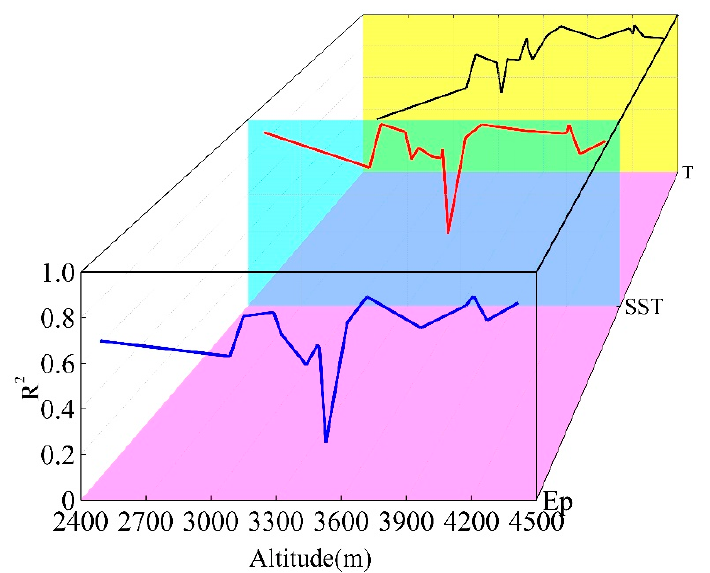
Figure 7. The relationship between prediction accuracy R 2 of the model integrating factors and altitude. The blue, red, and black polylines represent the factors Ep, SST, and T, respectively.